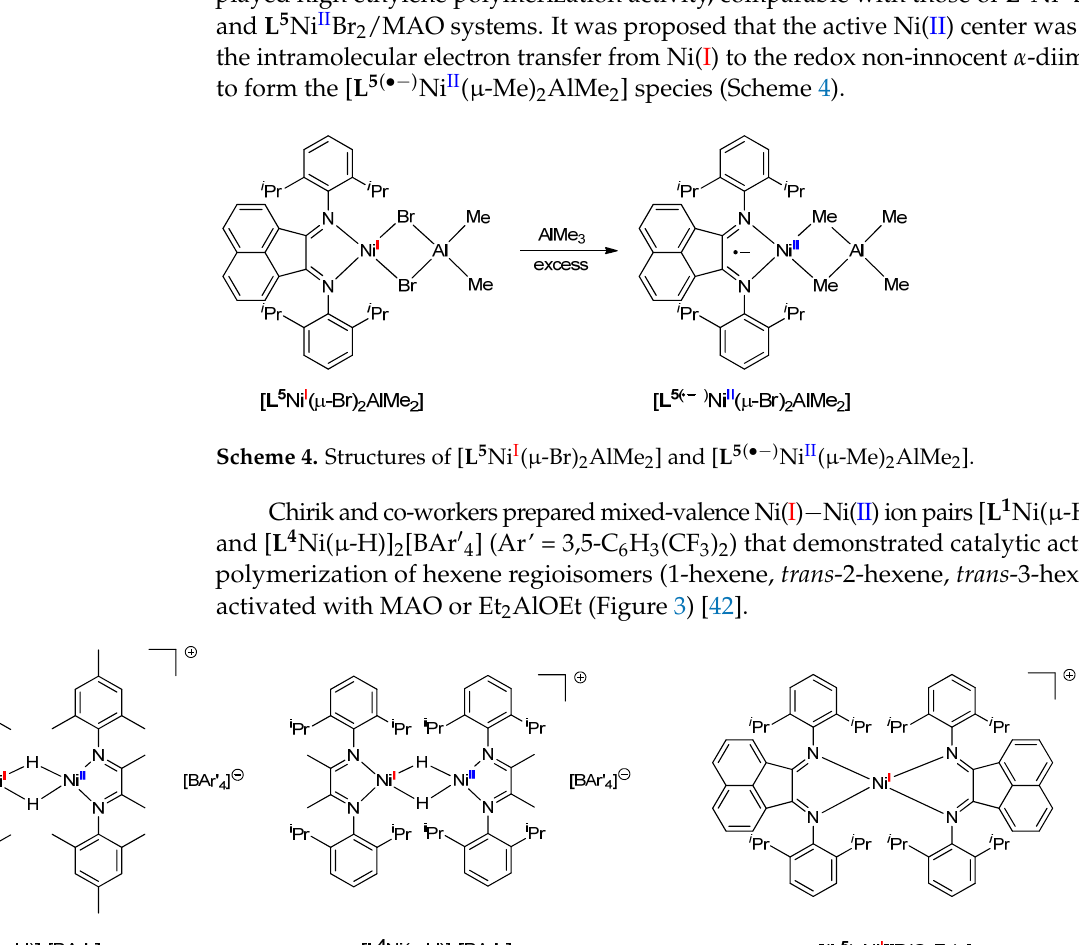
Figure 3. Structures of [ L 1 Ni( μ -H)] 2 [BAr ′ 4 ], [ L 4 Ni( μ -H)] 2 [BAr ′ 4 ], and [( L 5 ) 2 Ni I ][B(C 6 F 5 ) 4 ] (Ar ′ = 3,5-C 6 H 3 (CF 3 ) 2 ).